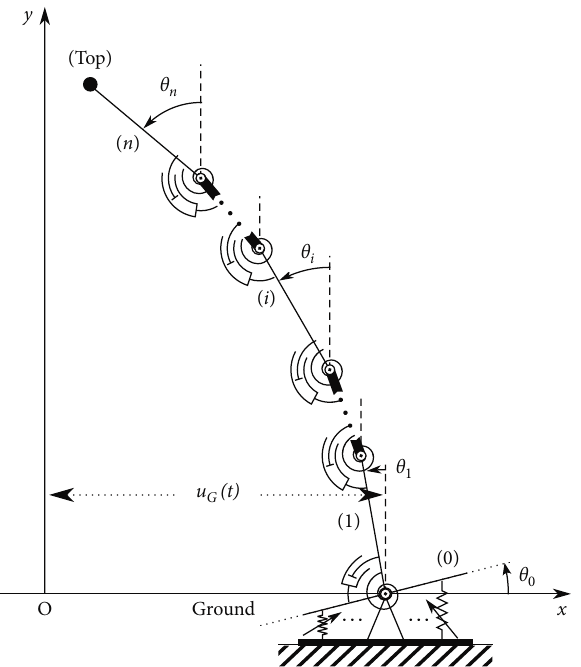
Figure 10: Reference frame and configuration of the isolated multibody system at some instant of